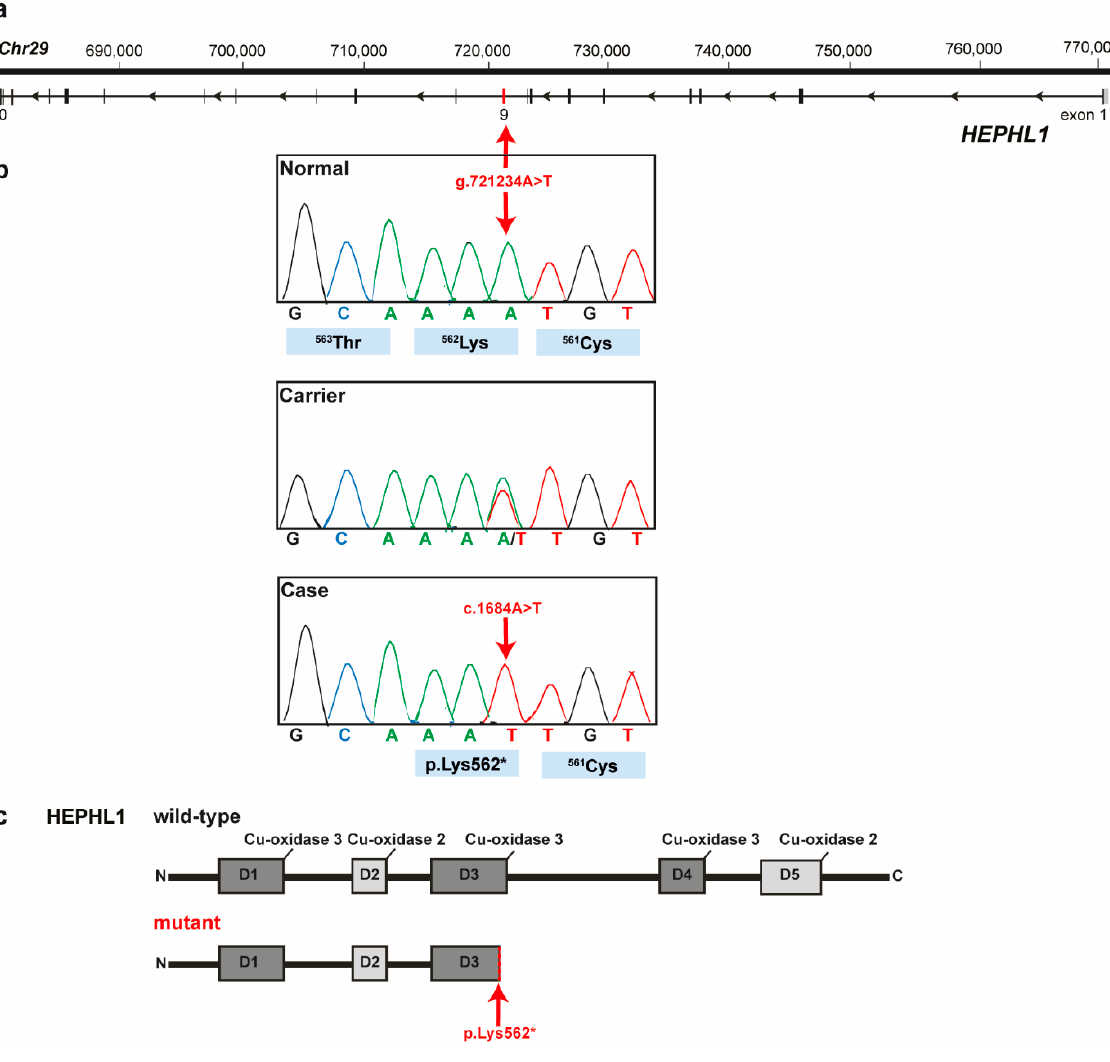
Figure 3. HEPHL1 nonsense variant in Belted Galloway cattle affected by congenital hypotrichosis. ( a ) HEPHL1 gene structure showing the location of the exon 9 variant on cattle chromosome 29. ( b ) Electropherograms showing the different genotypes identified via Sanger sequencing. ( c ) Schematic representation of HEPHL1 wild-type protein with its functional domains and the mutant protein. The wild-type protein is 1157 amino acid residues in length. The mutant protein is expected to be 562 amino acid residues in length due to the premature induction of a stop codon. D, domain.